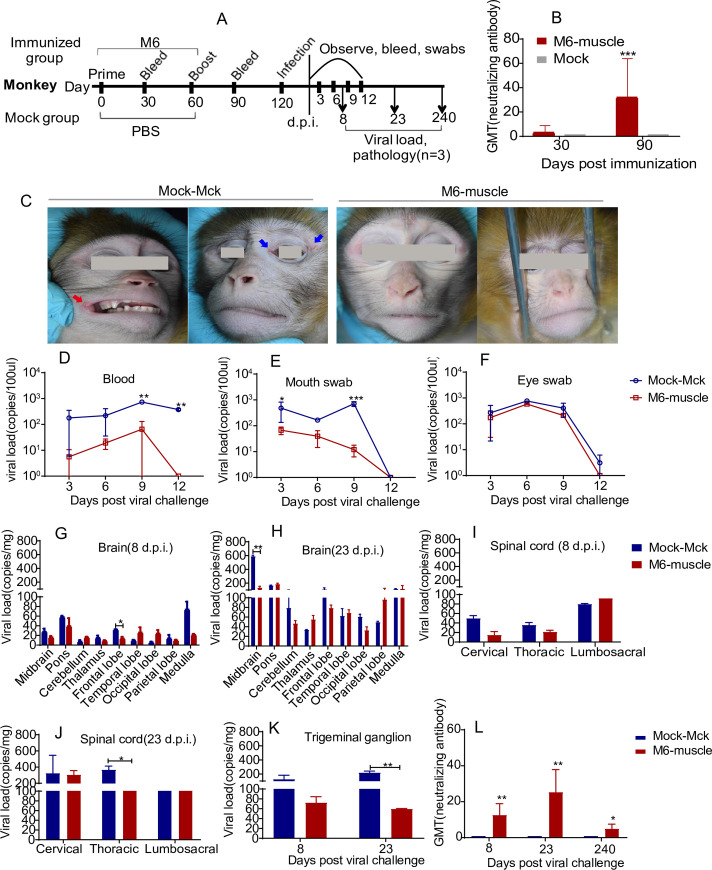
The immunoprotective efficiency of the strain M6 in a monkey model.(A) Design of the monkey experiment. (B) The neutralizing capability of antibodies specific for HSV-1 from M6-infected or mock-infected monkeys. (C) Manifestations including ulcerative lesions in the mouth (red arrow) or eye (blue arrow) of infected monkeys.(D-F)Viral loads in the blood(D), mouth swabs (E) and eye swabs (F) of infected monkeys during 12 days after viral infection. (G-K) Viral loads in the brain (G, H), spinal cord (I, J) and trigeminal ganglion (K) of infected monkeys at 8 or 23 d.p.i. (L)The neutralizing capability of antibodies specific for HSV-1 fromM6-infected or mock-infected monkeys at 8 or 23 d.p.i. or 8 month post-immunization. The values are presented as the mean ± SEM. *p< 0.05; **p< 0.01; ***p< 0.001.